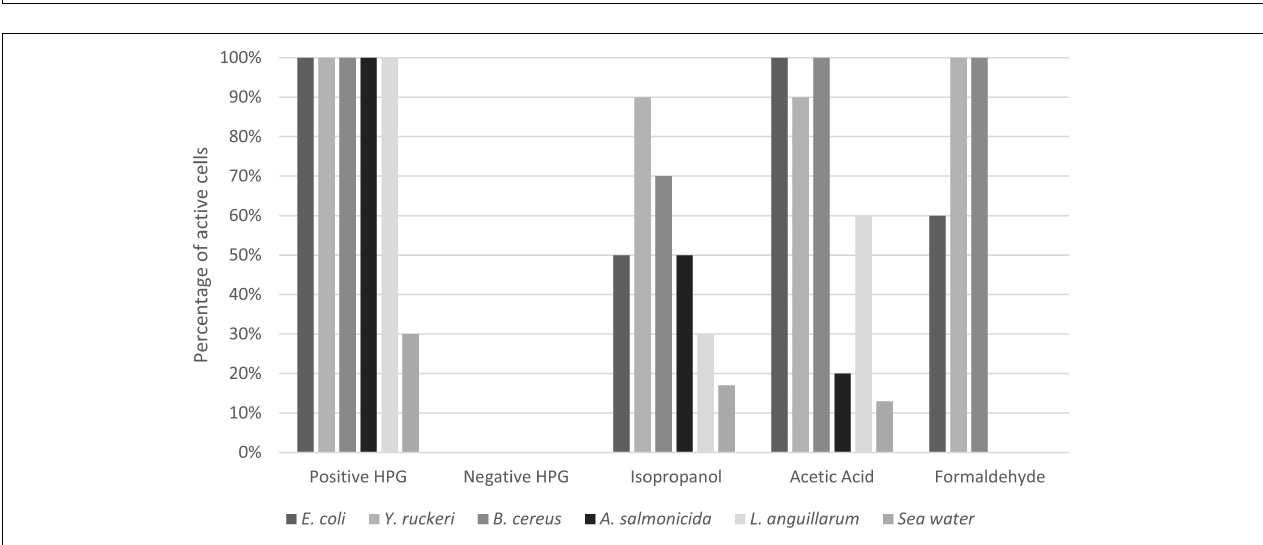
FIGURE 7 | Effect of different fixatives on HPG uptake in different bacteria. Positive HPG is live cells incubated with HPG, whereas negative HPG is the control sample incubated without HPG. The results for the different fixatives are expressed in percentage of active bacteria (number of positive HPG cells). The percentages were obtained by dividing the positive BONCAT cells (Q2) by the total cell number obtained from SYBR Green staining (Q1+Q2).